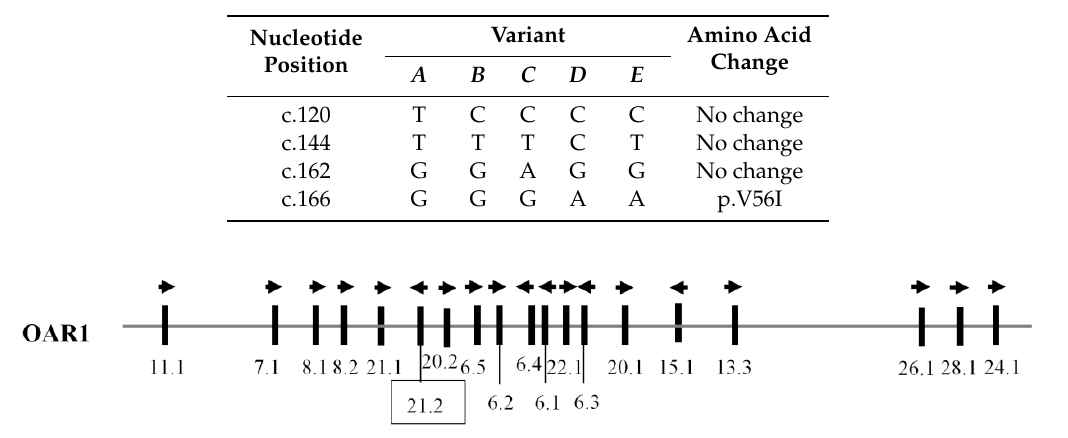
Table 1. Sequence variation identified in ovine KRTAP21-2 .